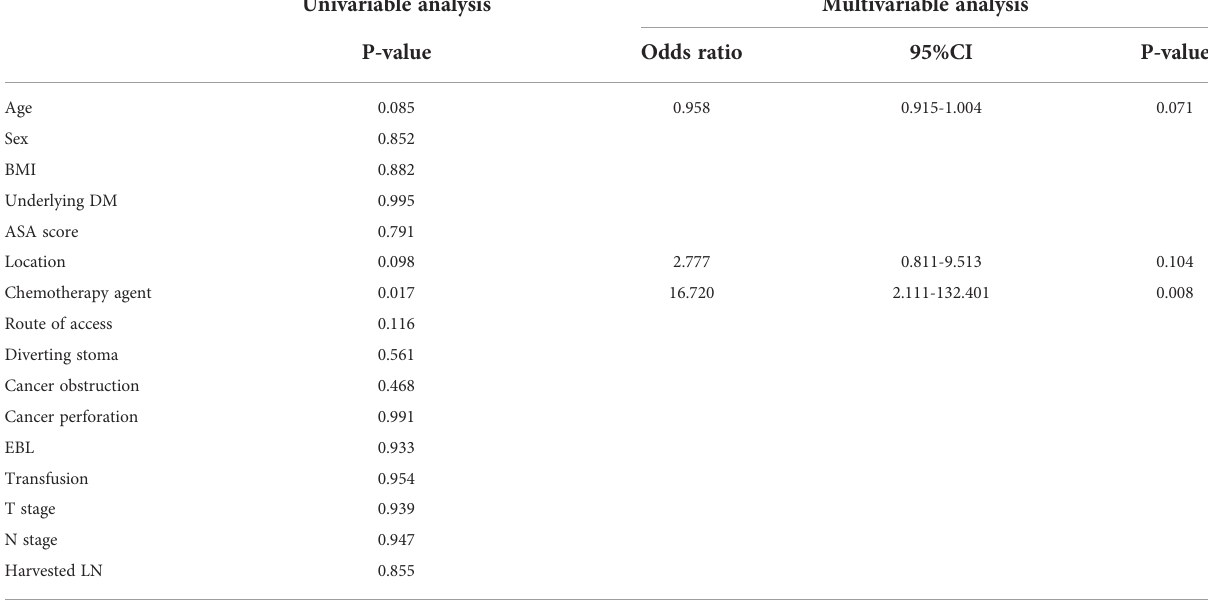
TABLE 4 Univariable and multivariable analyses of factors associated with anastomosis site leakage in stage IV colorectal cancer patients. Univariable analysis